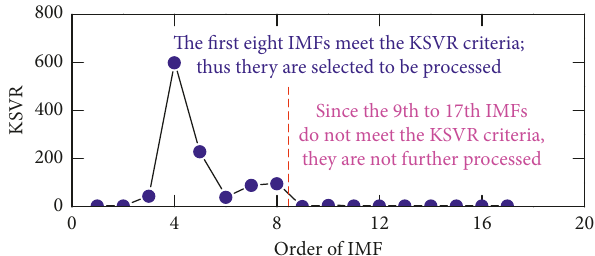
Figure 15: Kurtosis of the SVR spectra of the IMFs obtained by CEEMDAN for a roller fault